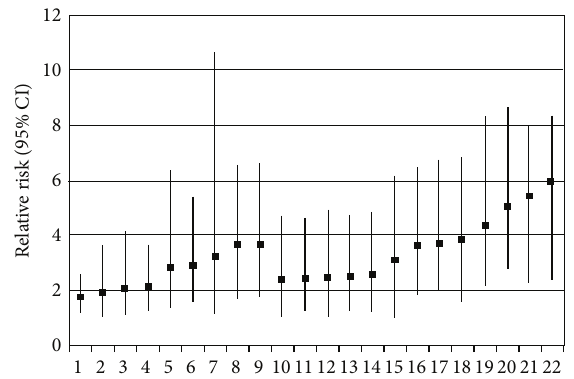
Figure 1: Estimated relative risk and 95% confidence intervals (CI) for poststroke hip fracture in older persons by selected clinical